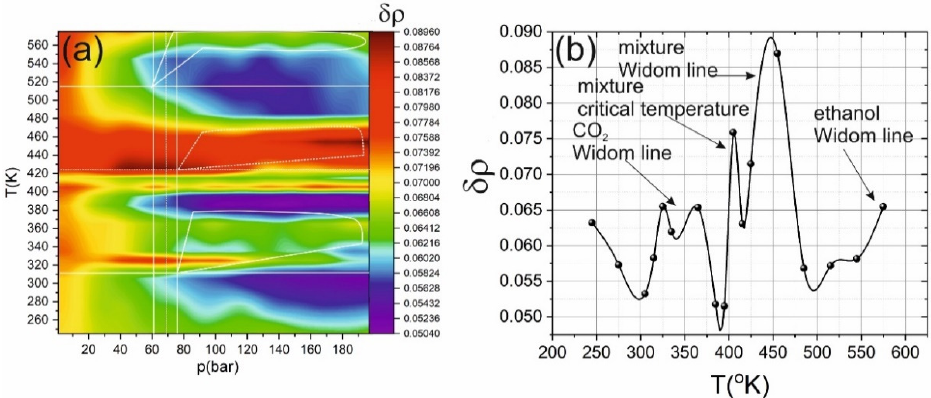
Figure 4. ( a ) Heat map of the maximum cluster size S max (number of molecules) dependence on pressure and temperature. The solid lines show the critical temperatures and pressures of carbon dioxide and ethanol; the white dashed line shows the mixture critical point. The highlighted areas correspond to the Widom delta (solid lines for carbon dioxide and dashed lines for mixtures). ( b ) Dependence of the maximal cluster size on temperature under pressure of 161 bar. Figure 5. ( a ) Heat map of the density fluctuations δρ / δ p dependence on pressure and temperature. Solid lines show the critical temperature and pressure of carbon dioxide and ethanol; dashed lines show mixture parameters. The highlighted areas correspond to the Widom delta (solid lines for carbon dioxide and dashed lines for mixtures). ( b ) The dependence of density fluctuations δρ on temperature from Figure 5a under pressure of 161 bar.